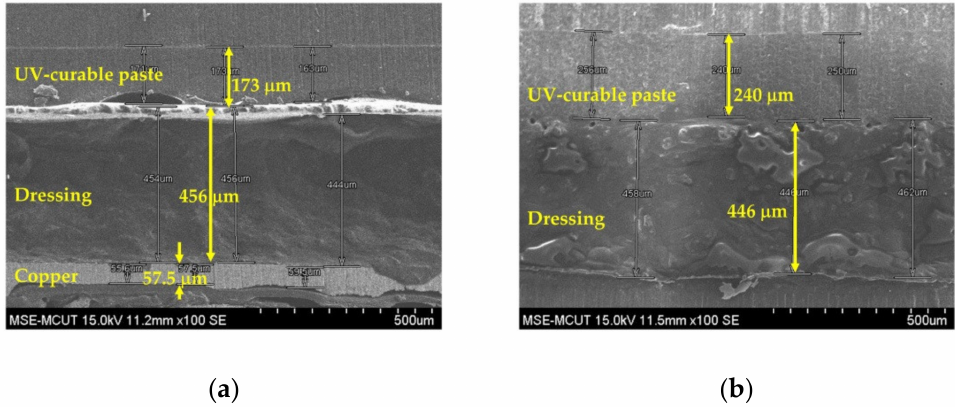
Figure 5. Cross section of SEM images for screen-printed UV-curable paste on the wound-dressing: ( a ) one pass and ( b ) two passes.